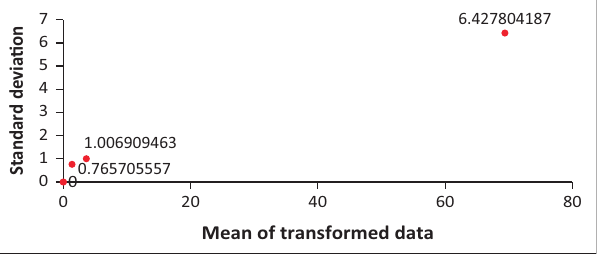
FIGURE 1: Bartlett’s test for homogeneity of variances. TABLE 5: Bartlett’s test for homogeneity of variances ( p = 7.520). Variables